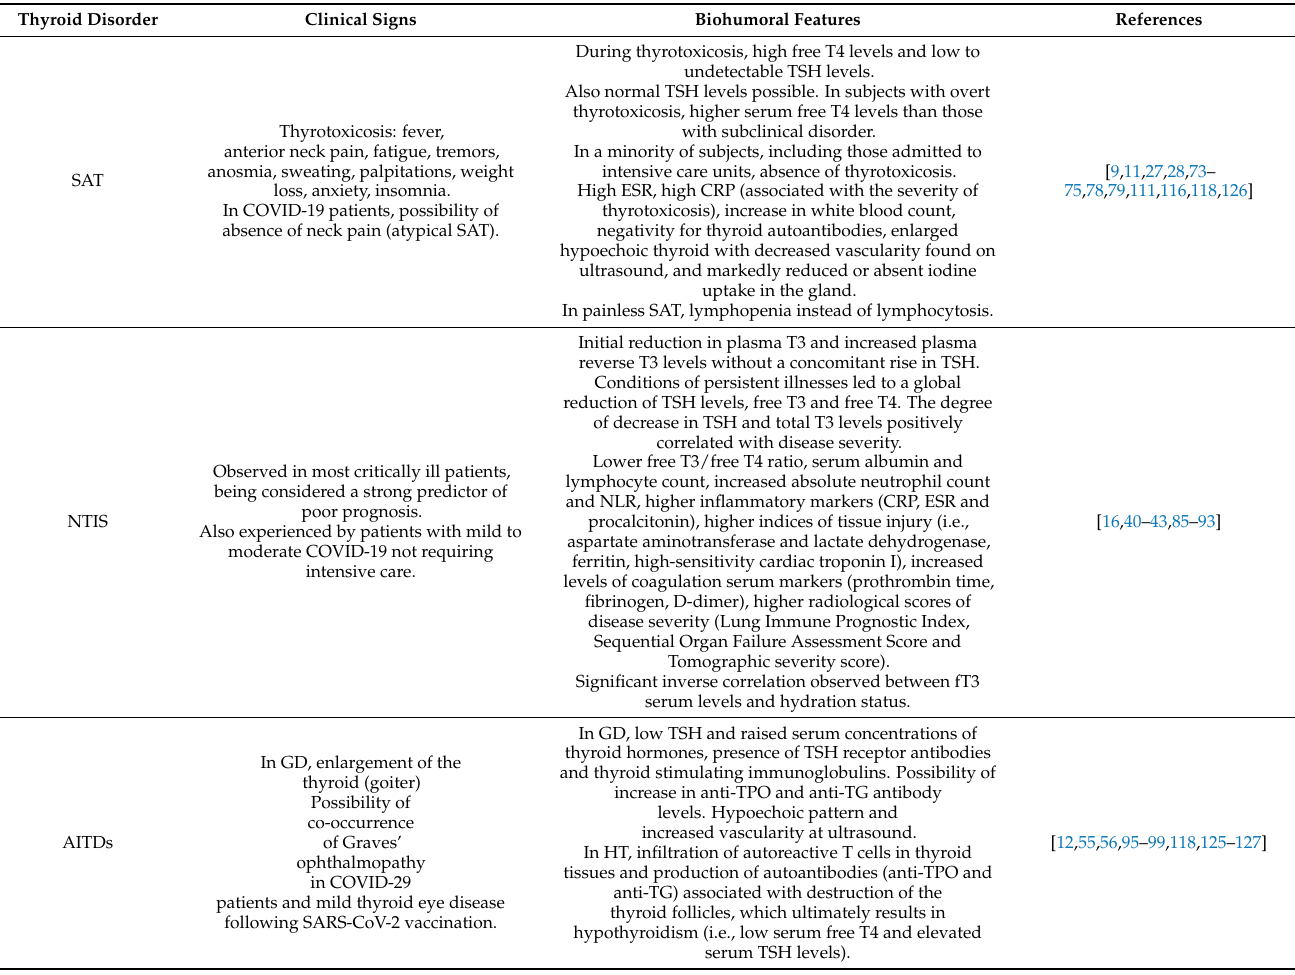
Table 4. Summary of main clinical and biohumoral findings in thyroid disorders after SARS-CoV-2 infection and